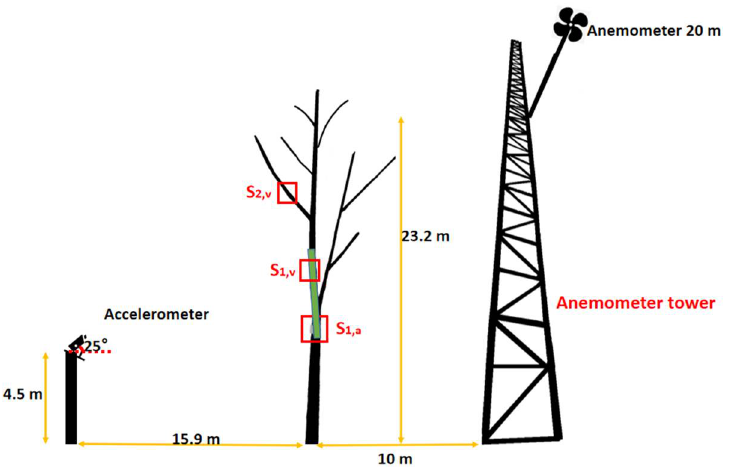
Figure 1. Schematic diagram of the test system.